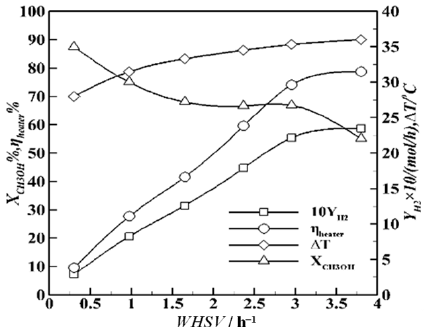
Figure 9. Variation in Y H 2 , X CH 3 OH , and Δ T of module (1), as well as η heater , with reforming channel inlet WHSV.